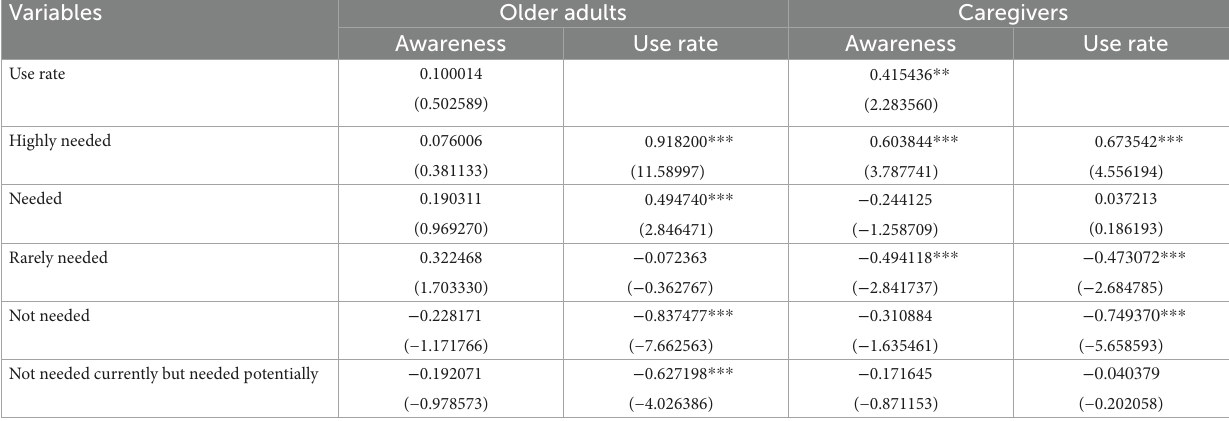
TABLE 1 Correlation between awareness, use and need of SG&Ss, older adults and caregivers.